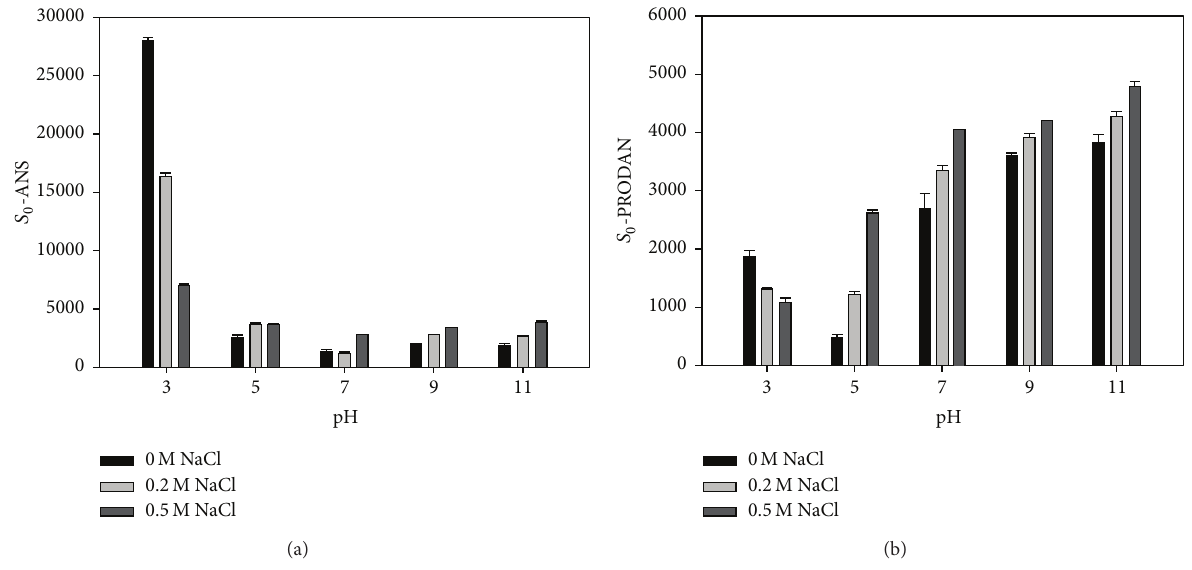
Figure 4: Effect of pH and NaCl concentration on the surface hydrophobicity (S 0 ) in SP from jumbo squid mantle, using the probes (a) ANS and (b) PRODAN. Data represent the mean ± standard deviation ( 𝑛 = 3 ).